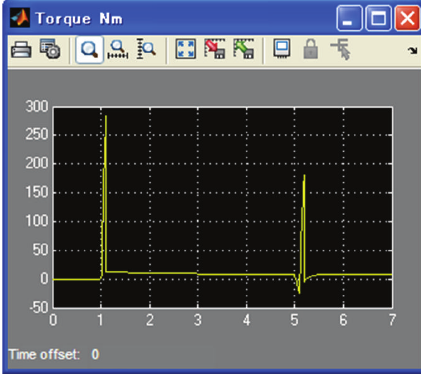
Figure 20: Simulation